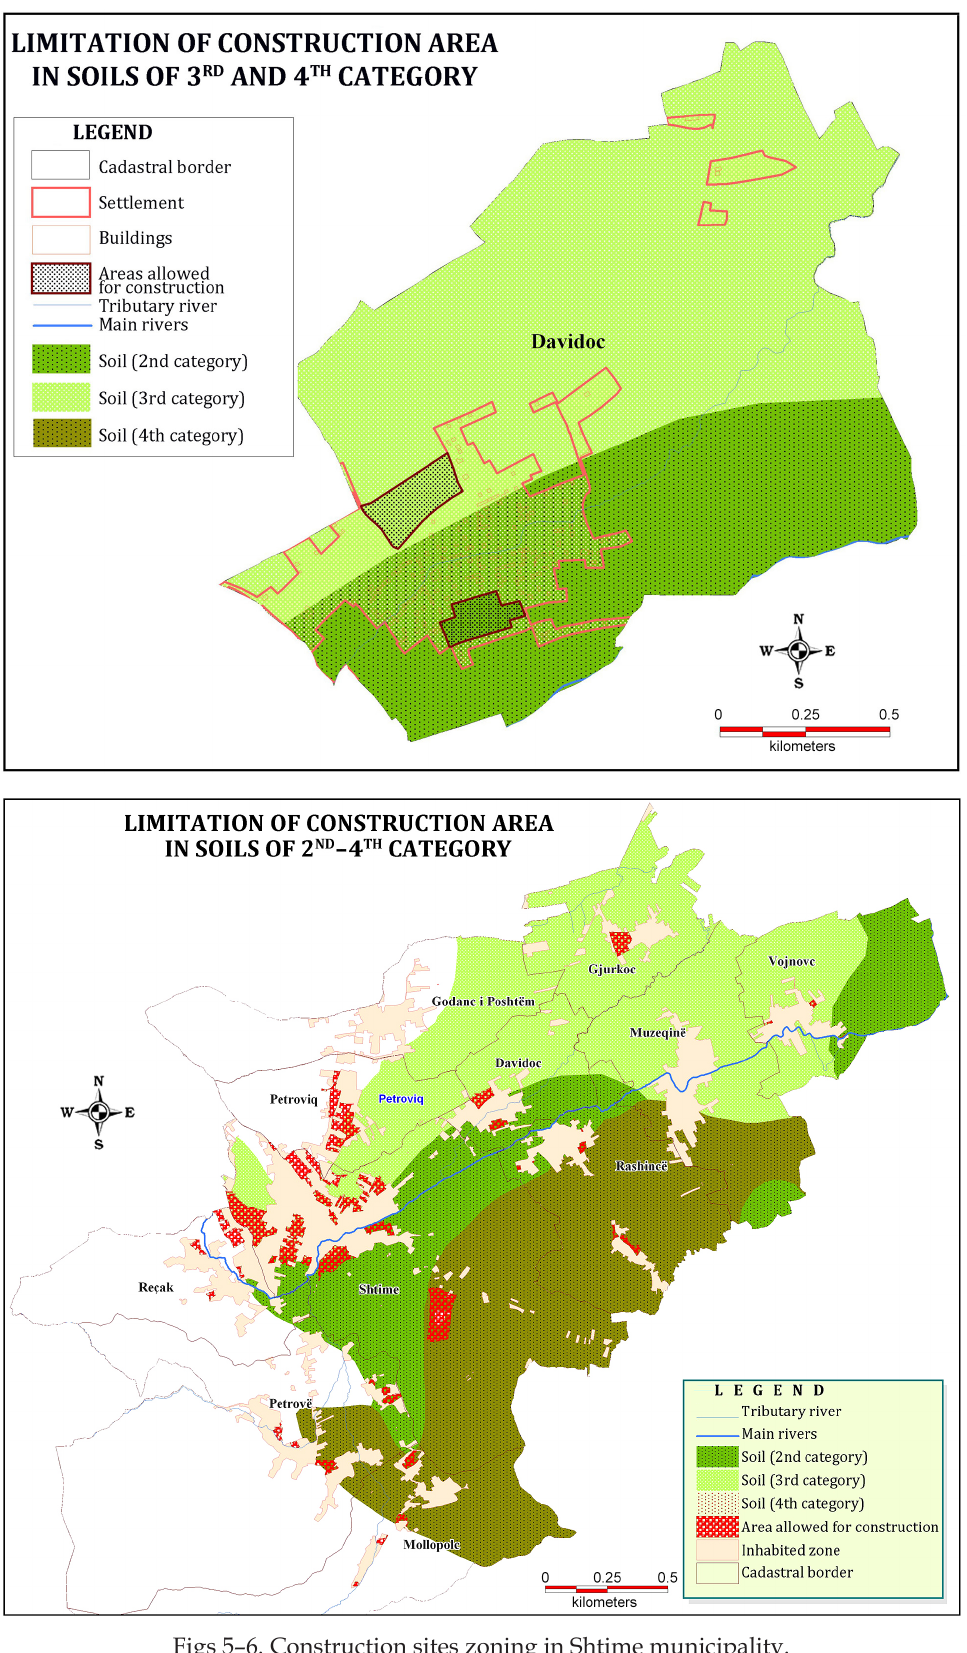
Figs 5–6. Construction sites zoning in Shtime municipality. Source: Ramadani, Shtime municipality